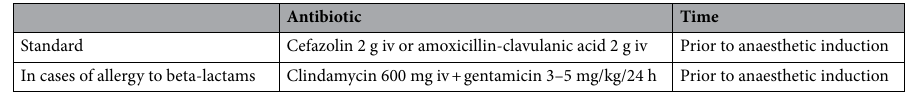
Table 1. Antibiotic prophylaxis protocol in otorhinolaryngological surgery.